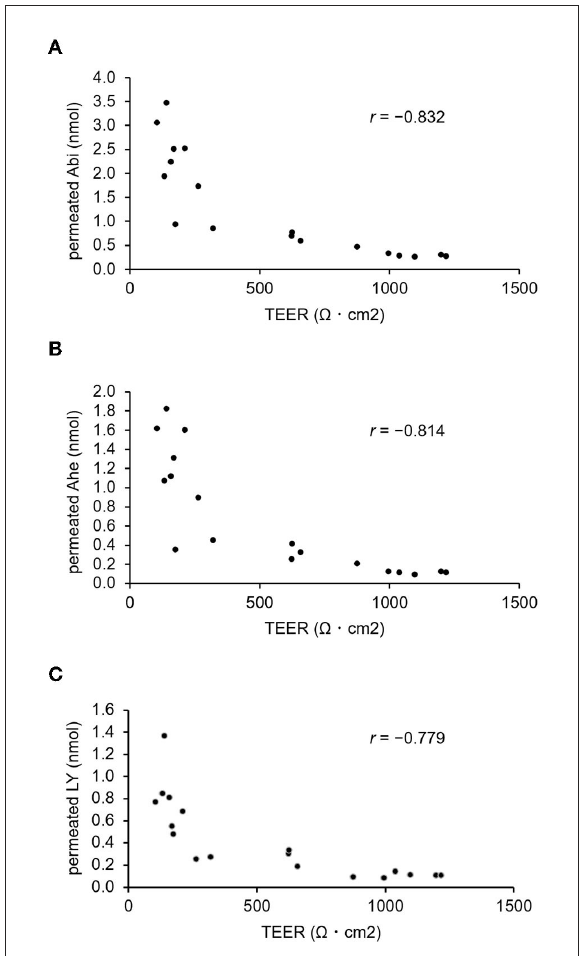
FIGURE6 Correlation between the amount of permeated AOSs and the TEER value of Caco-2 cell monolayers. The Pearson correlation coefficient value ( r ) between the TEER and the amount of Abi (A) or Ahe (B) that permeated the Caco-2 cell monolayers is compared with that of Lucifer yellow (C)